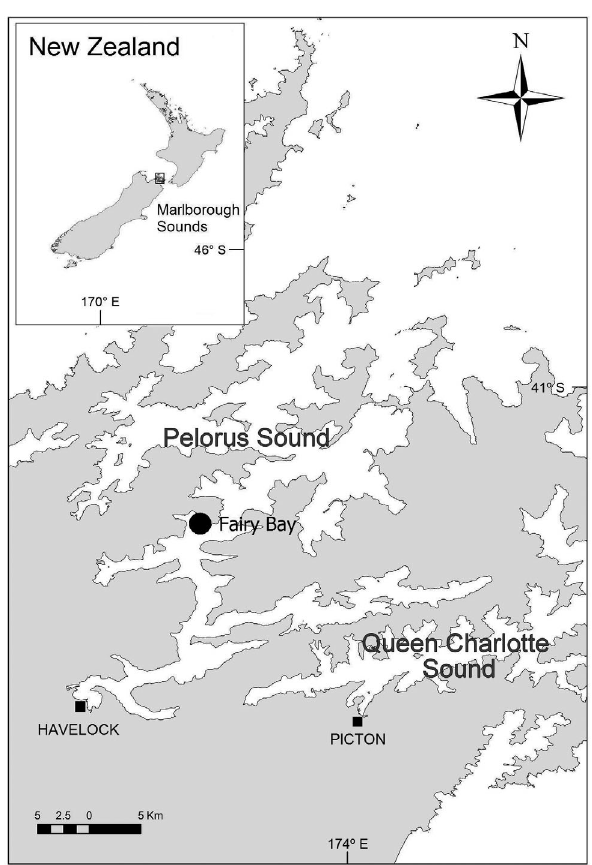
Fig. 1. Marlborough Sounds region (inset: location within New Zealand). The study site at Fairy Bay is indicated